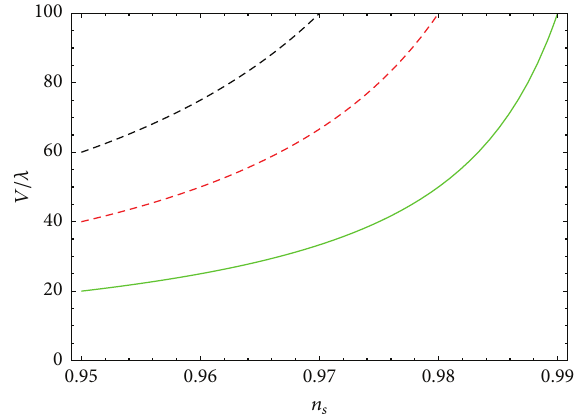
Figure 12: In this graph we plot the tachyonic potential in terms of the spectral index 𝑛 𝑠 . We can find best fit of high energy limit 𝑉 ≫ 𝜆 with the Planck